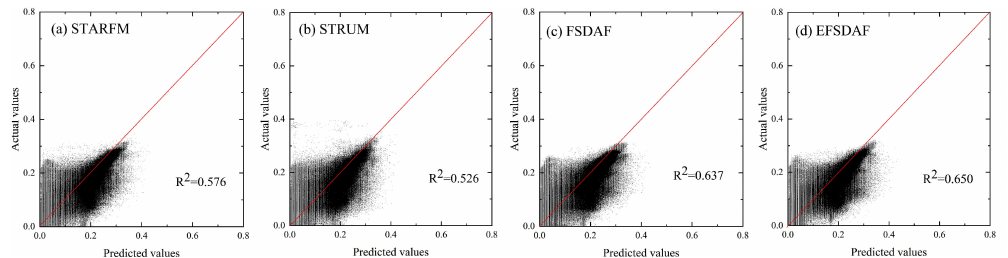
Figure 9. Scatter plots of the true values and the predicted values for NIR band in dataset 2. From left to right, ( a – d ) the scatter plots for STARFM, STRUM, FSDAF and EFSDAF,